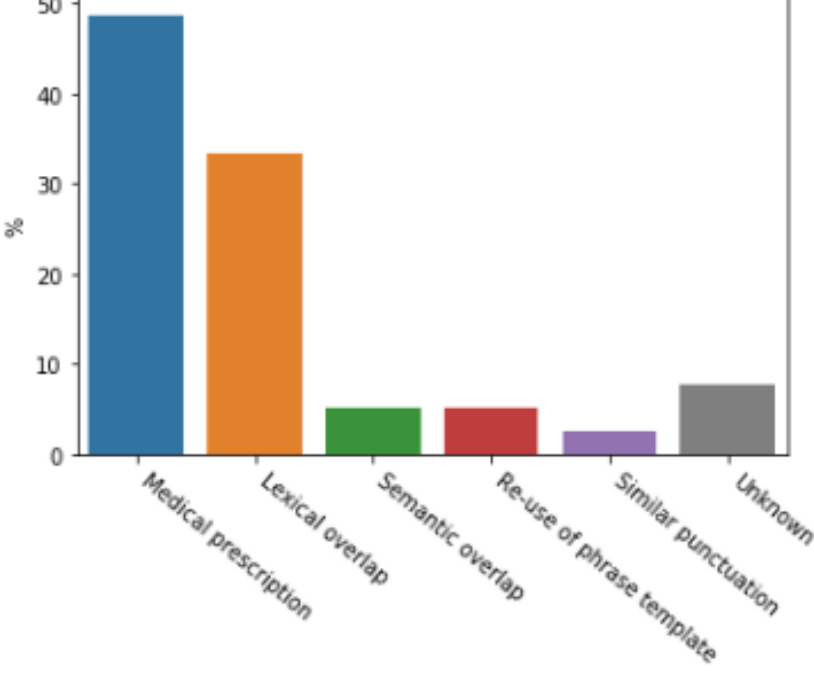
Figure 2. Common categories of error for cases when the model over-predicts similarity as identified by manual analysis of the 100 worst predictions.